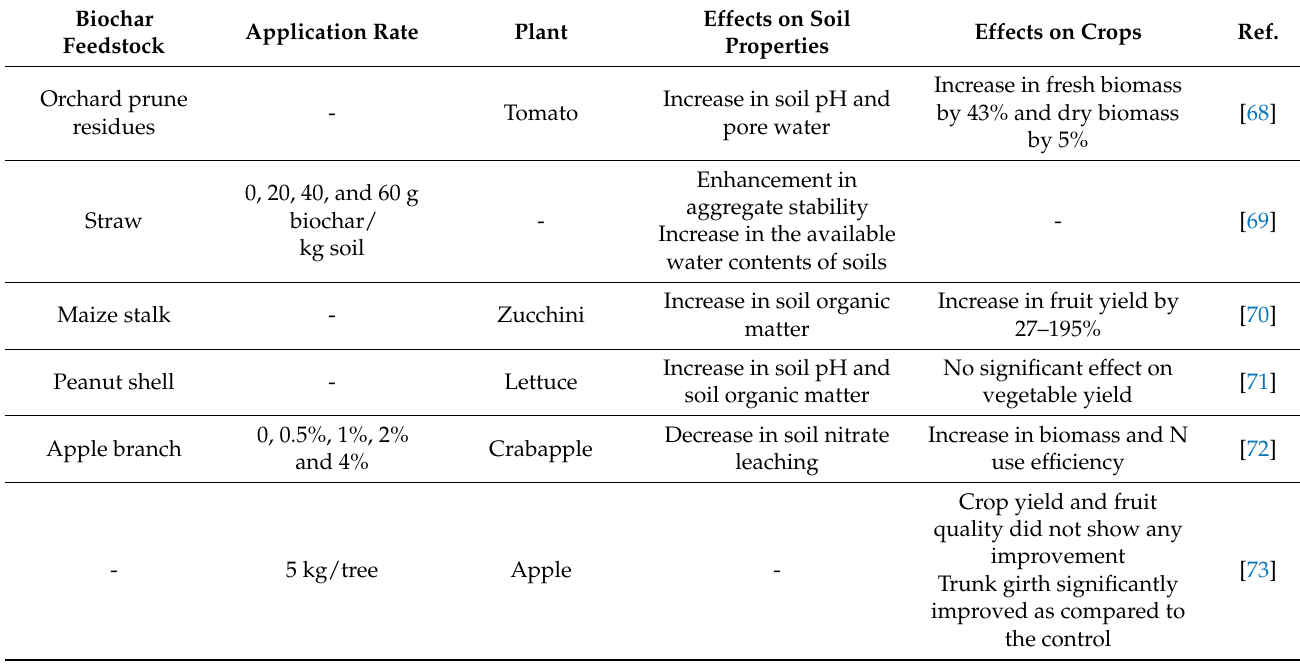
Table 2. Influence of biochar application on soil properties and agricultural product yield .